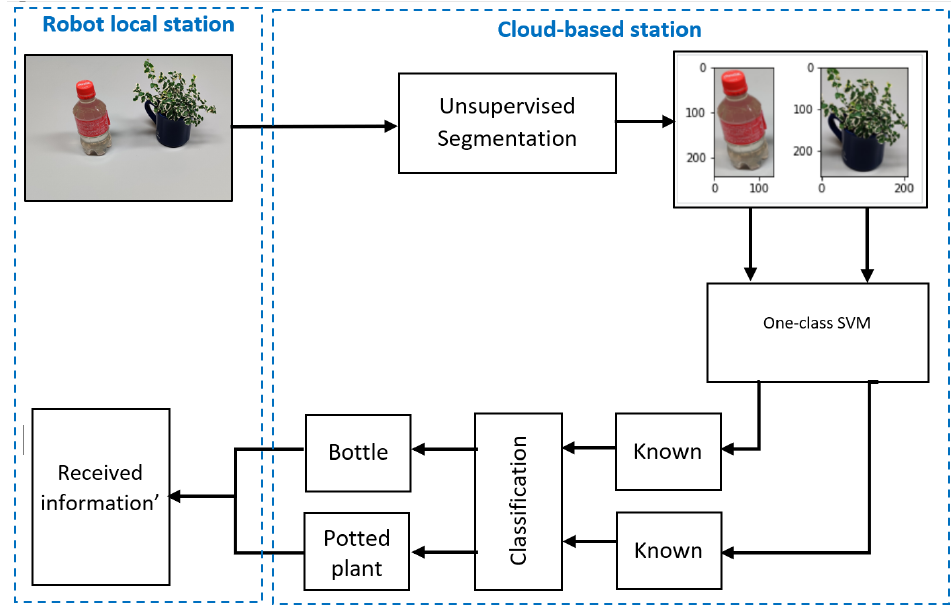
Figure 16. Schematic diagram for a single image in the multirobot experiment. Table 5. Results for multiple robot nodes simultaneously sending data to the cloud-based station and receiving analysis information.